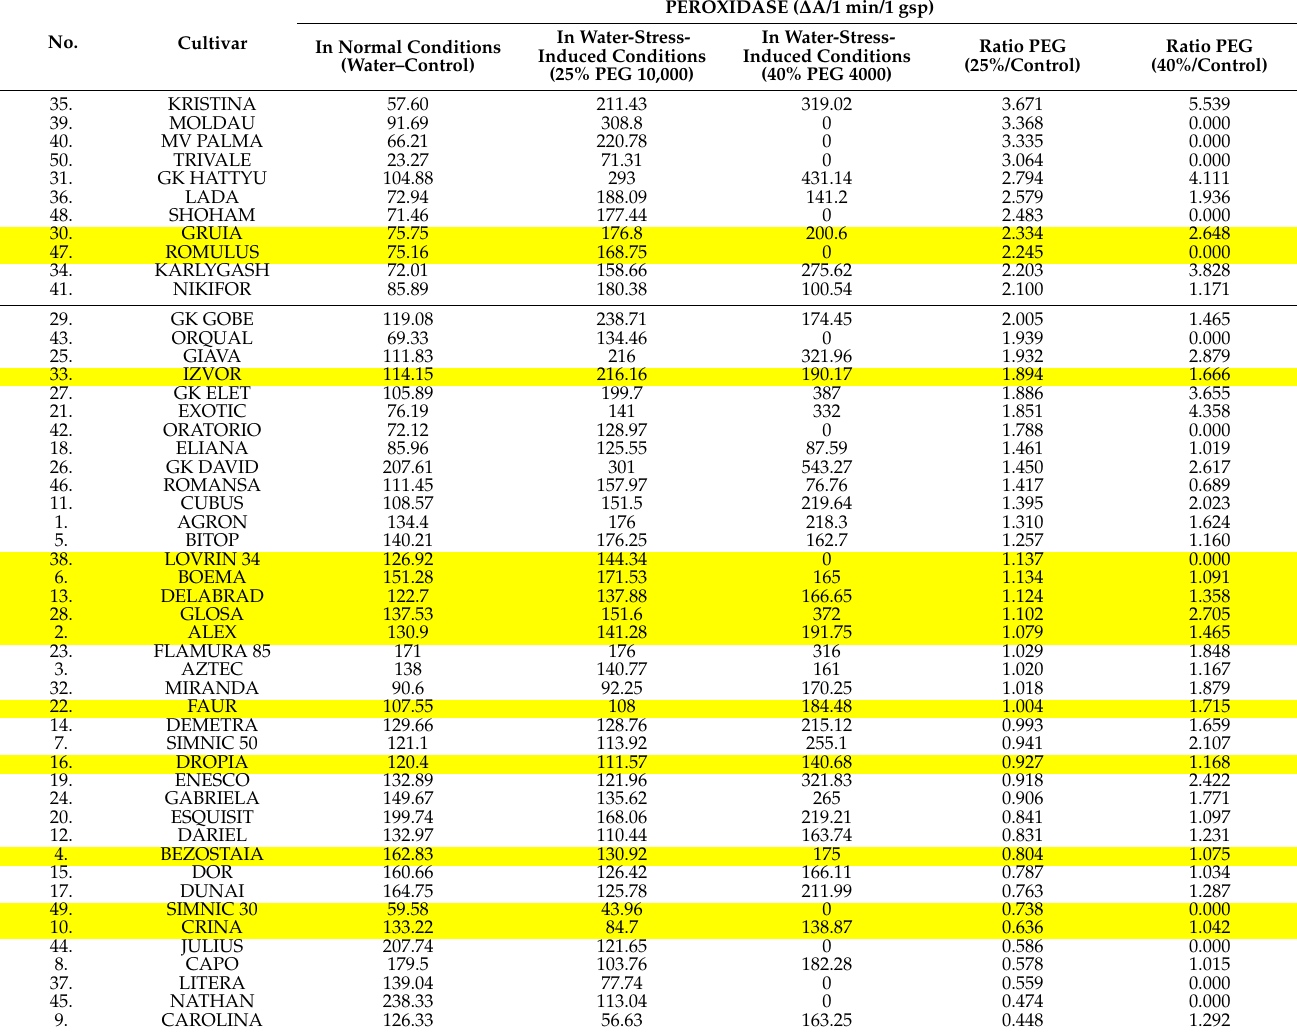
Table 1. The activity of peroxidase in an assortment of 50 wheat cultivars